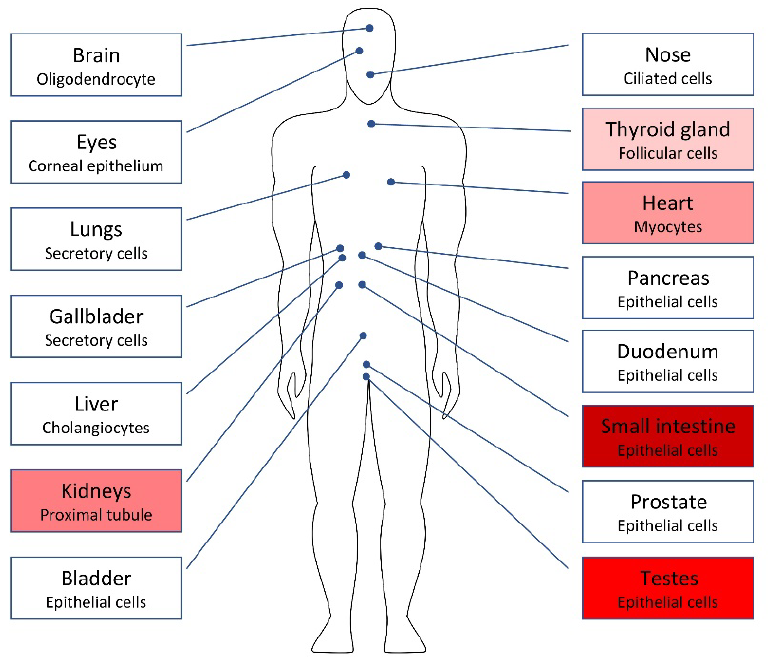
Figure 2. The distribution of angiotensin-converting enzyme-2 receptors (ACE2r) throughout the male body. In red scale, the 5 organs (starting with small intestine and testes) with the widest distribution of ACE2r (Ref. [74]). A large presence of ACE2r is also found in adipose tissue, the breast and colon (not shown).